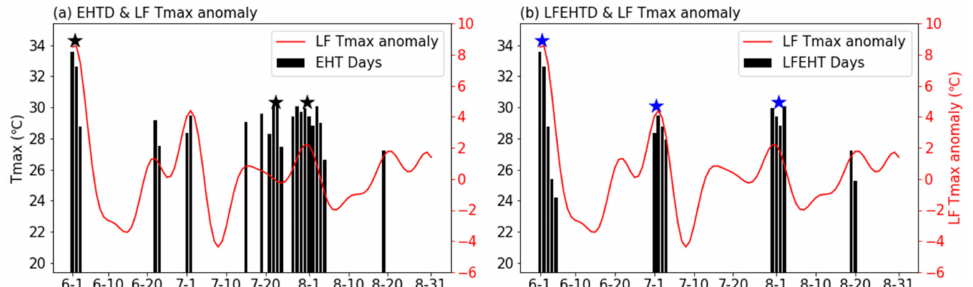
Figure 2. EHTs ( a ) and LFEHTs ( b ) in summer from 1981 to 2019 in northeast China and their frequencies ( c ). R in ( c ) is the correlation coefficient.